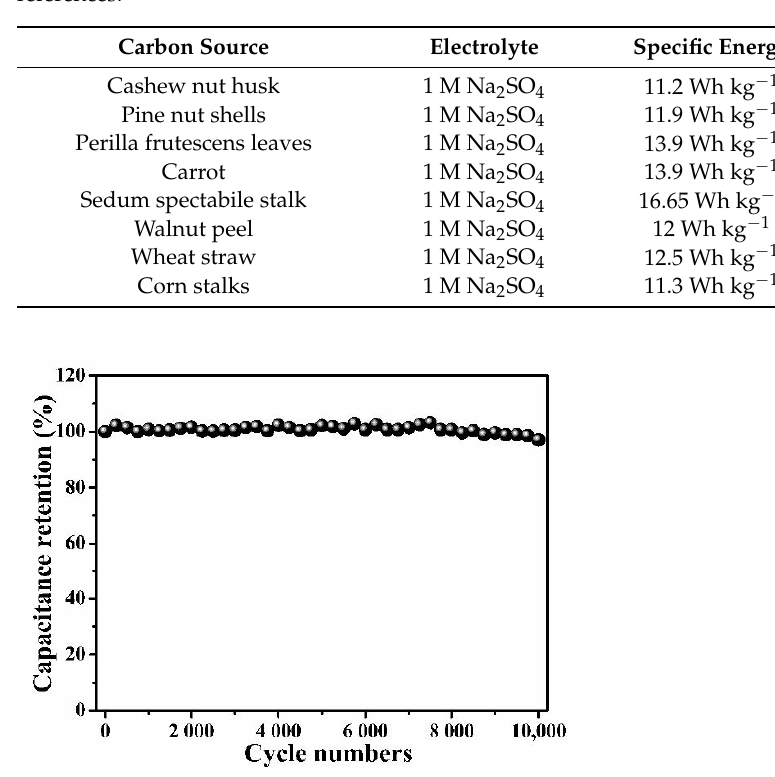
Figure 10. Cycling stability of the B/S-SC S -1// B/S-SC S -1 symmetric supercapacitor using 1 M Na 2 SO 4 electrolyte at 10 A g − 1 . Table 3. Comparison of the specific energy value of the supercapacitor with biomass carbon in re- cent references.